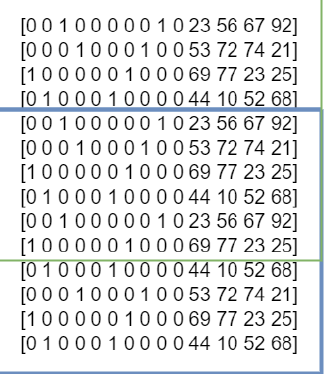
Figure 3. Sample with length equal to 10 with the shift of